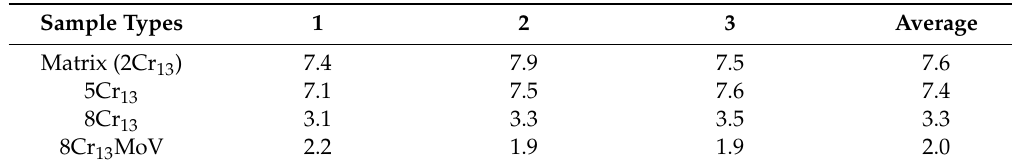
Table 5. Wear weight loss of matrix and the di ff erent surfacing layer (mg).